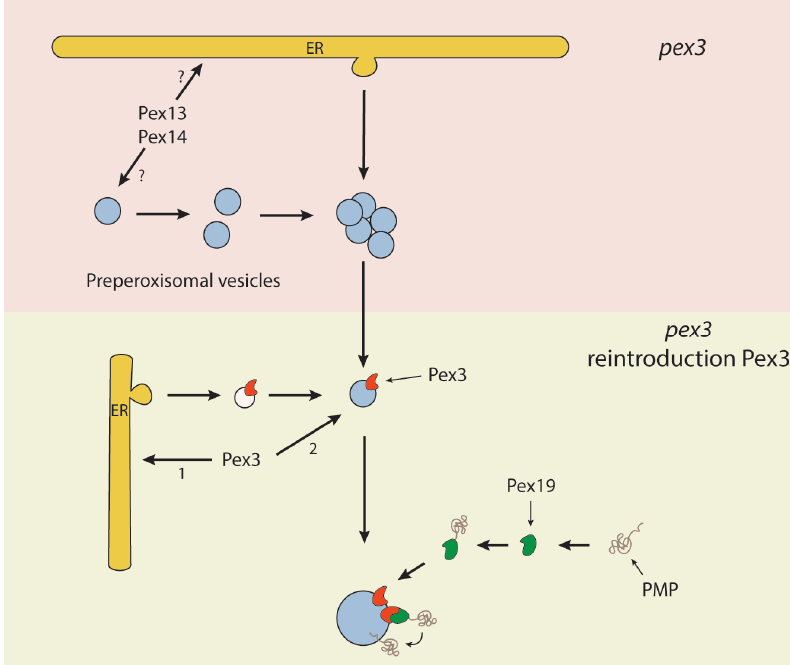
FIGURE 2: Schematic overview of the novel peroxisome biogenesis pathway. The upper pink part represents the presence of pre- peroxisomal vesicles, containing Pex13 and Pex14, in yeast PEX3 deletion cells. These vesicles may be autonomous and proliferate by fission or form from the ER in a Pex3/Pex19 independent manner. Upon